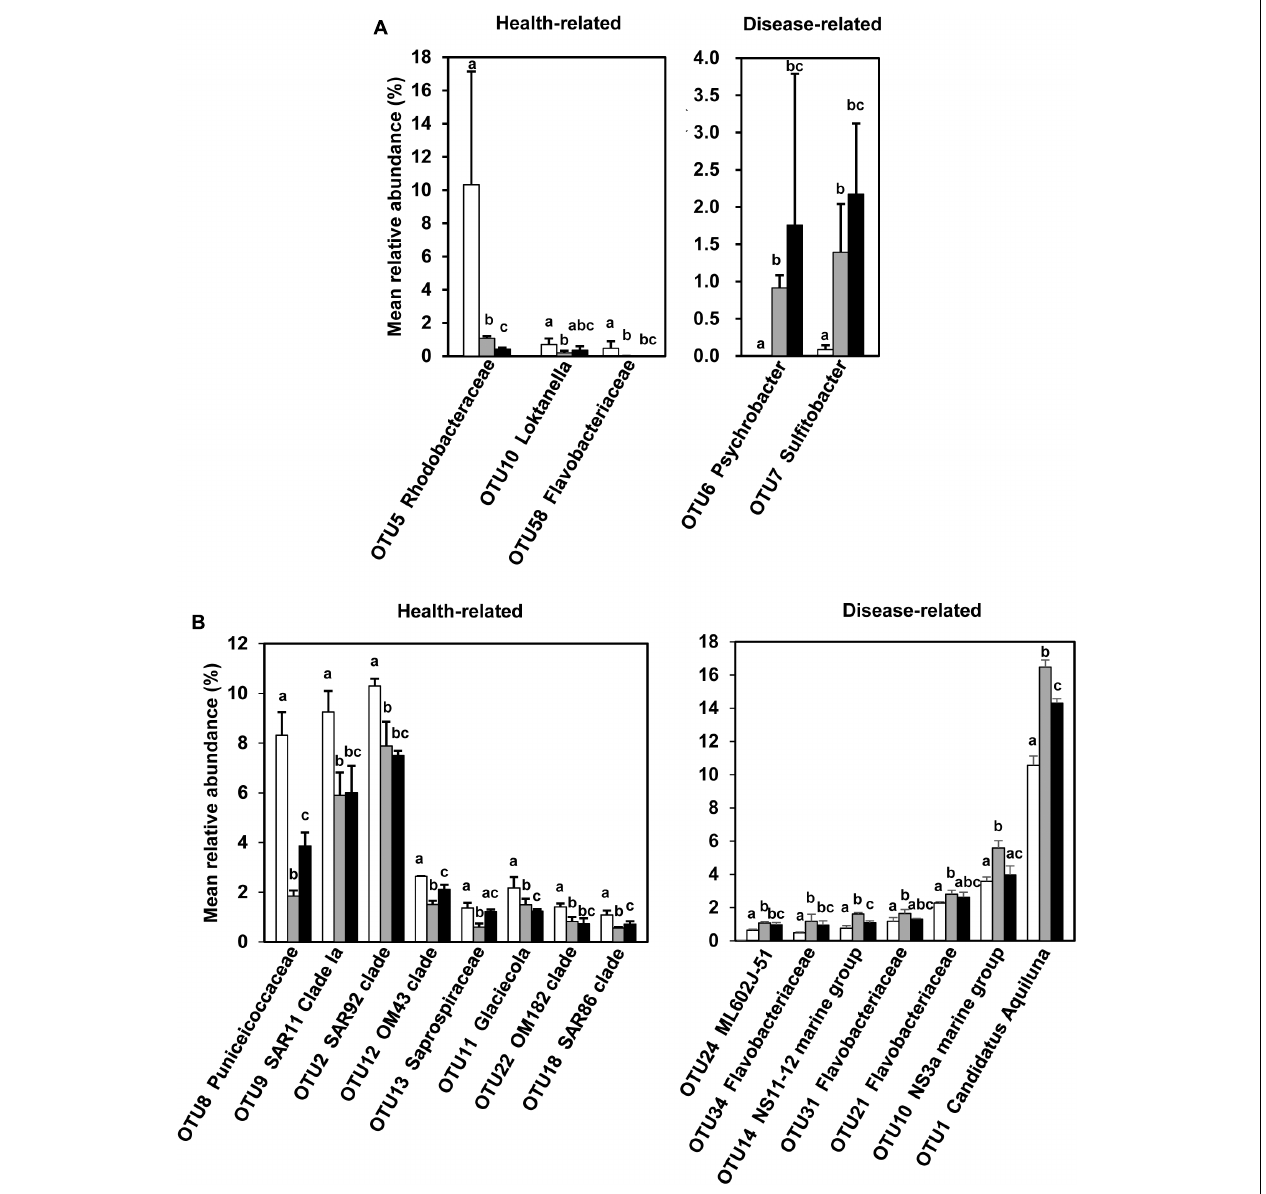
FIGURE 5 | Screened health-status related bacterial OTUs and the comparisons of their relative abundance across the three groups. (A) Screened bacterial OTUs associated with Pyropia yezoensis . (B) Screened bacterial OTUs associated with seawater. White, gray, and black bars represent relative abundances of bacterial OTUs in the H, D, and DW datasets, respectively. The error bars indicate standard deviations, and the letters on the error bars indicate significant differences ( P < 0.05) based on unpaired wilcoxon rank sum tests.